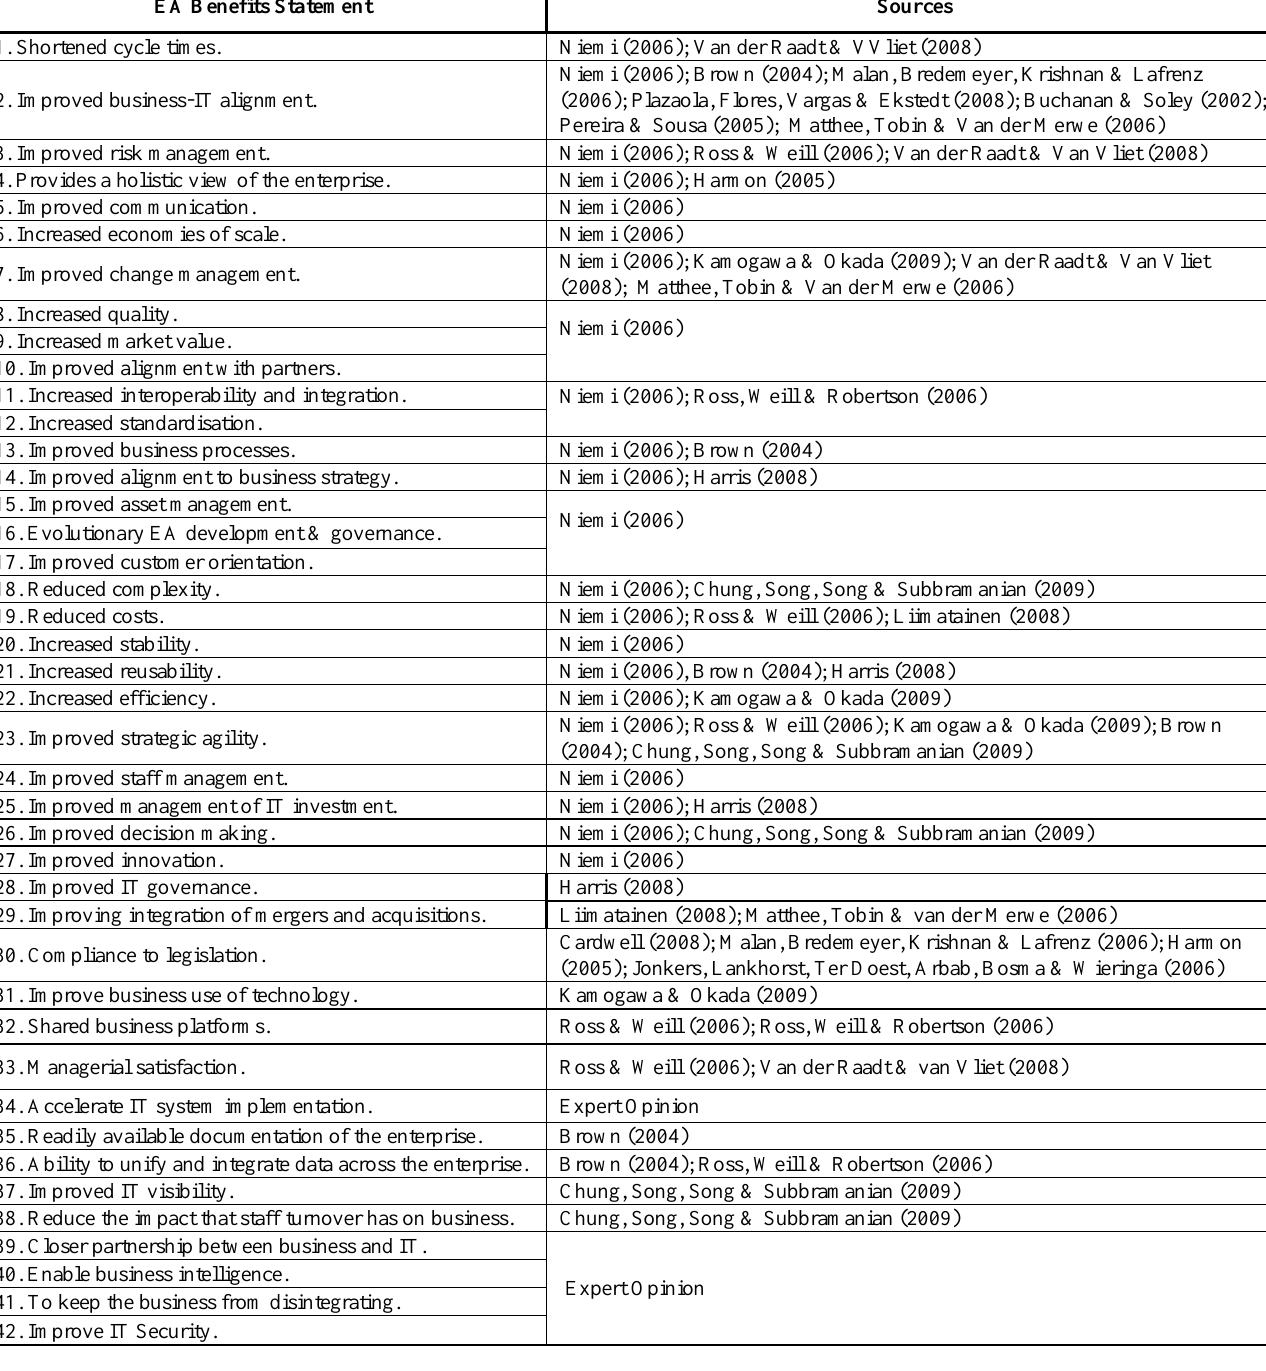
Table 4: Factor variance & eigenvalues